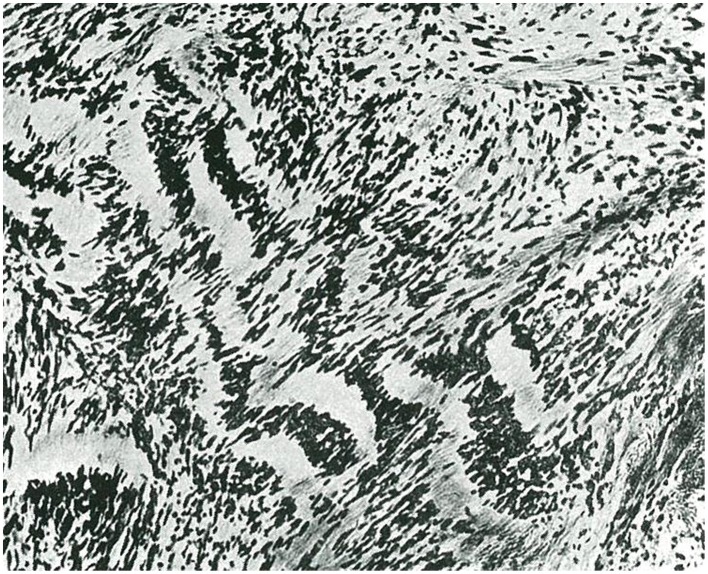
Neurinoma. Grouping of the nuclei in rows or palisades (taken from Río-Hortega, 1933a).